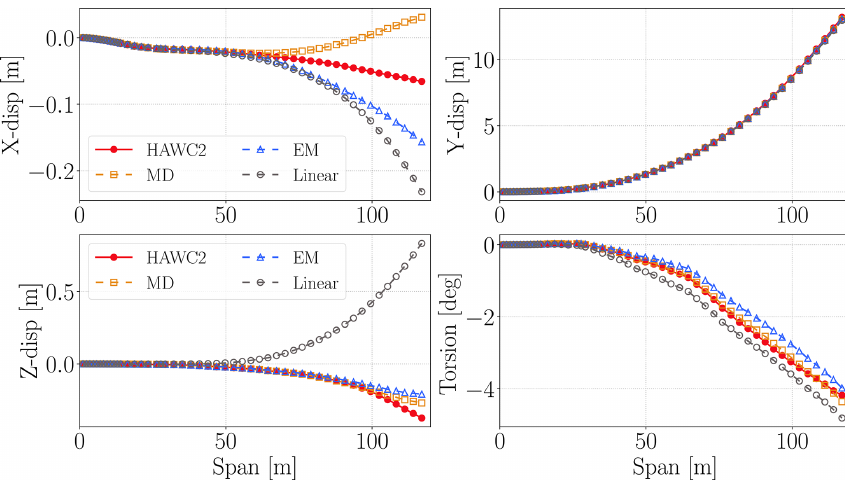
Figure 14. Spanwise deflection results at the time when the maximum torsion occurs (67.5s).